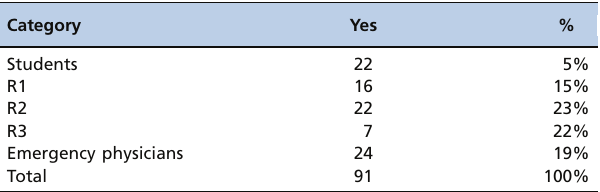
Table 4 - Percentage of physicians who considered themselves able to set the PSV mode.